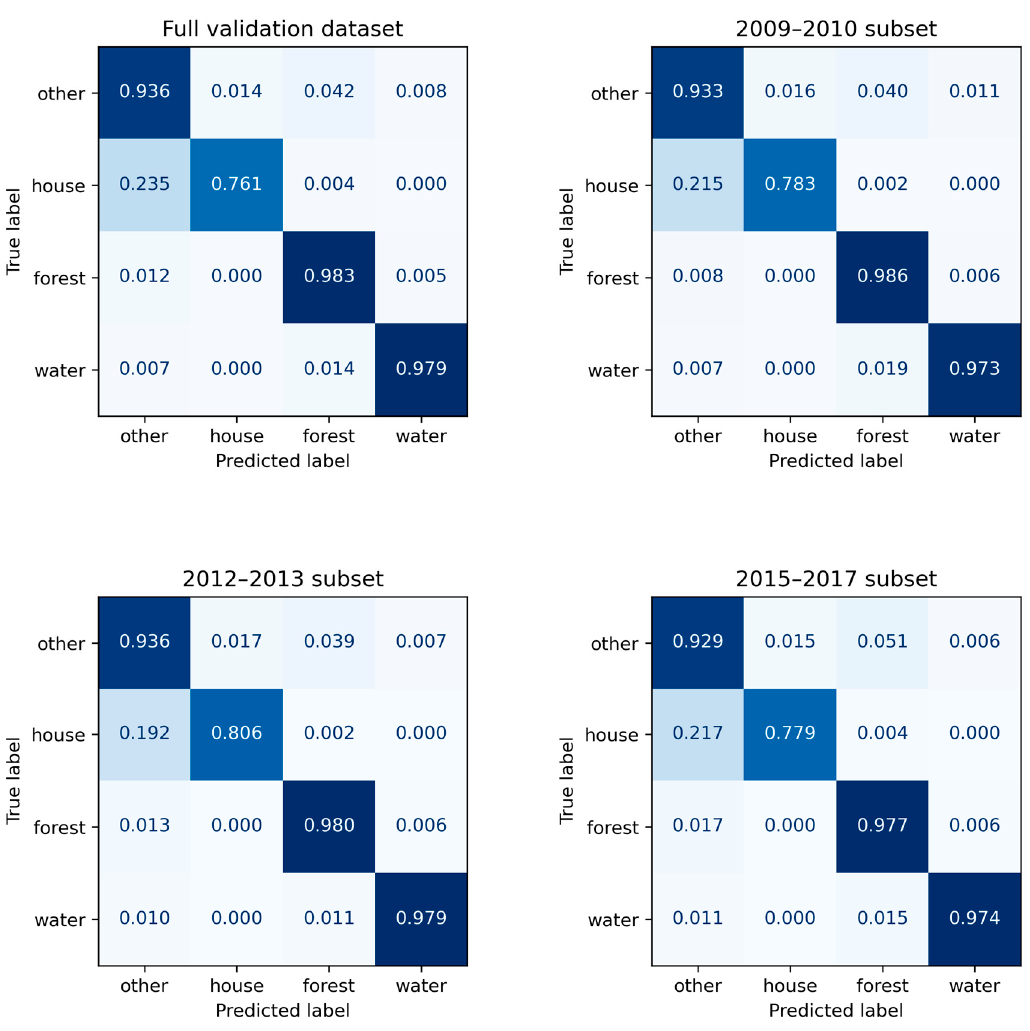
Figure 9. Normalized confusion matrix of M123 segmentation results for full fine-tuning validation set and its subsets of different periods.